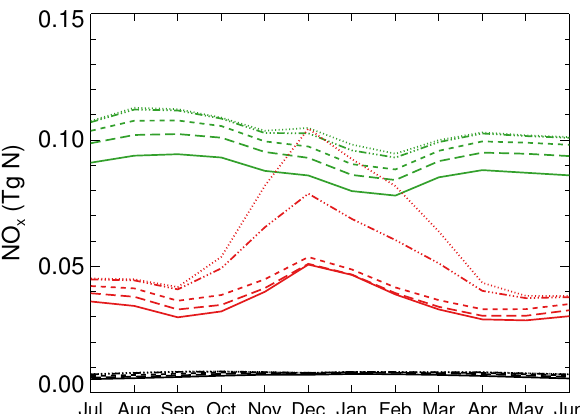
Fig. 1. Impact of γ N on the NO x burden in the northern extra- 2 O 5 tropics (90 ◦ N–30 ◦ N, red lines), southern extra-tropics, (30 ◦ S– 90 ◦ S, black), and tropics (30 ◦ N–30 ◦ S, green) for five of the simu- lations. Different γ N values are represented by the line-style as 2 O 5 follows: Dotted γ = 0 . 0; dot-dash γ = 0 . 001; dashes γ = 0 . 02; long dashes γ = 0 . 1; solid γ = 1 .